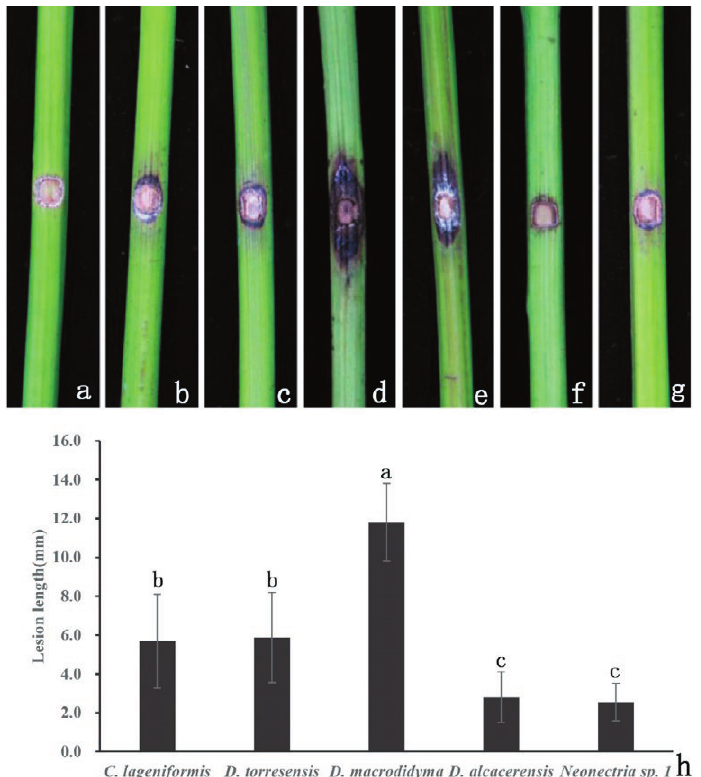
Figure 5. Pathogenicity tests results (after 7 d) of BF fungal agents inoculated onto detached green shoots of grapevine ‘Summer Black’. Control ( a ) , Cylindrocladiella lageniformis ( b ), Dactinonectria torresensis ( c ), D. macrodidyma ( d and e ), D. alcacerensis ( f ), or Neonectria sp. 1( g ). Histogram ( h ) of mean lesion lengths on wood shoots after inoculations with the different fungi. Means accompanied by different let- ters are significantly different ( P = 0.05)